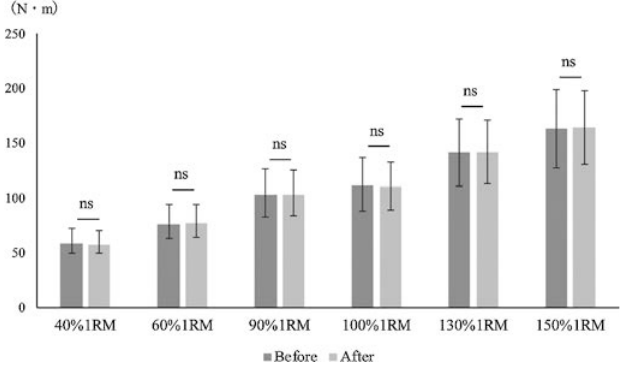
Figure 7 Correlation coefficient between angular velocity and average torque after modification of the leg extension machine.